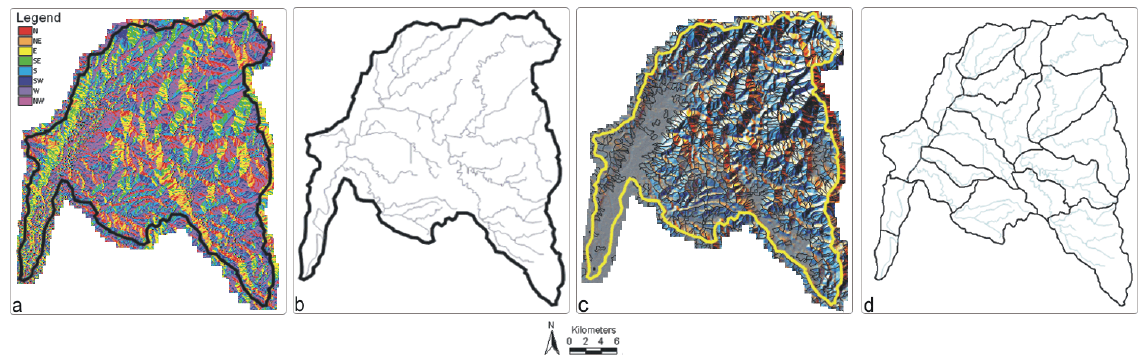
Fig. 4. Maps generated from DEM-Hydroprocessing (a) flow direction map, (b) drainage network map, (c) sub-basin map, and (d) merged sub-basin